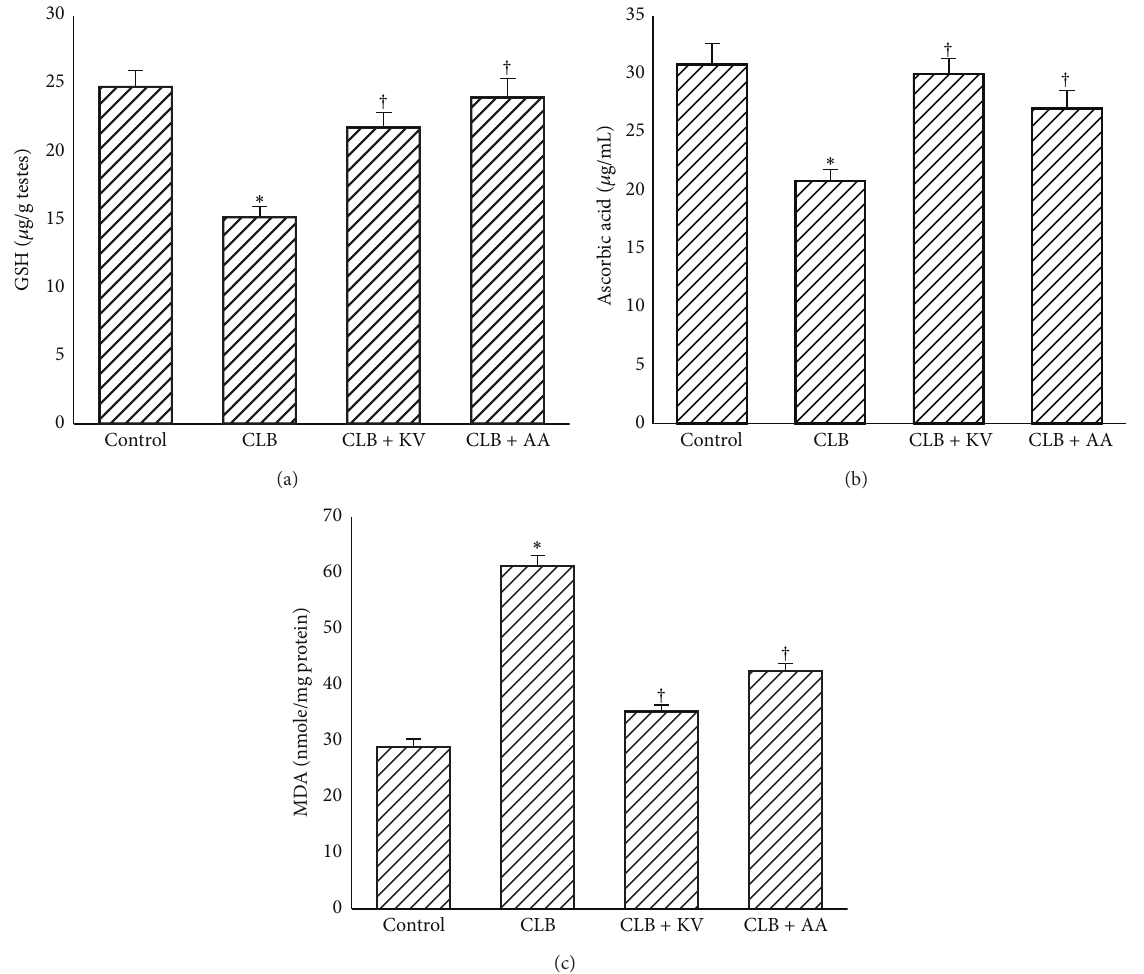
Figure 2: Protective effect of kolaviron and L-ascorbic acid on chlorambucil-induced changes in testicular level of GSH, ascorbic acid, and MDA in rats. Results are expressed as mean ± S.D (𝑛 = 5) ; GSH: reduced glutathione, MDA: malondialdehyde, CLB: chlorambucil (0.2mg/Kg b.w.), KV: kolaviron (100mg/Kg b.w.), and AA: ascorbic acid (100 mg/Kg b.w.). ∗ Significantly different from CTRL; † Significantly different from